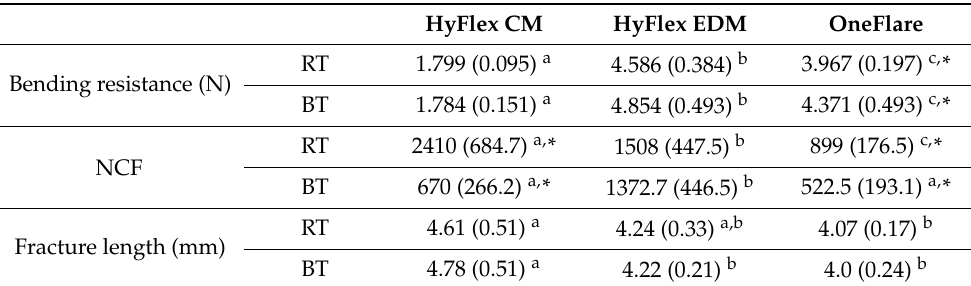
Table 2. The bending resistance, number of cycles to failure (NCF) and fracture length of HyFlex CM (CM), HyFlex EDM (EDM), and OneFlare (OF). HyFlex CM HyFlex EDM OneFlare RT 1.799 (0.095) a 4.586 (0.384) b 3.967 (0.197) c, * Bending resistance (N) BT 1.784 (0.151) a 4.854 (0.493) b 4.371 (0.493) c, * RT 2410 (684.7) a, * 1508 (447.5) b 899 (176.5) c, * NCF BT 670 (266.2) a, * 1372.7 (446.5) b 522.5 (193.1) a, * Fracture length (mm)